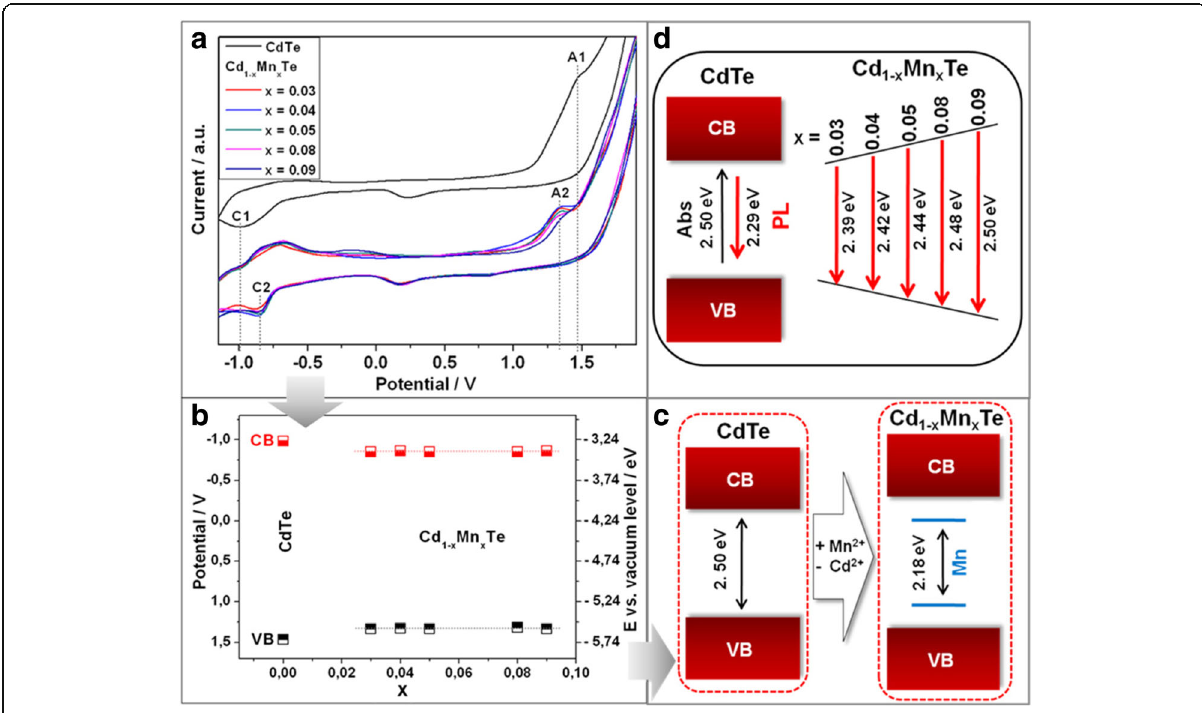
Fig. 3 Cyclic voltammograms of colloidal CdTe and series of Cd 1-x Mn x Te-alloyed QDs with different Mn 2+ ions content ( a ). Plot of valence (VB) and conduction (CB) band edge positions for CdTe and the series of Cd 1-x Mn x Te-alloyed QDs, obtained from the respective anodic (A) and cathodic (C) peak positions ( b ). Scheme of the electrochemical ( c ) and optical ( d ) signal